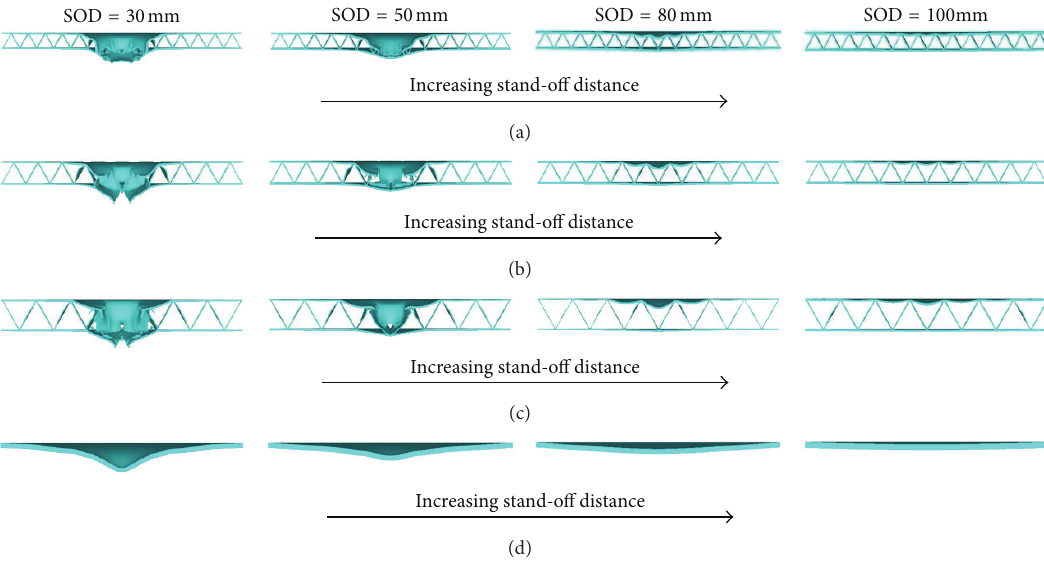
Figure 13: Cross-sectional view of the deformation/failure modes of sandwich panels and equivalent solid plates under different stand-off = 1.0 mm, and 𝑙 = 20 mm; (b) 𝑡 distances. (a) 𝑡 𝑓 = 2.0 mm, 𝑡 c = 5.8 𝑙 = 40 mm; (d) 𝑡 𝑠